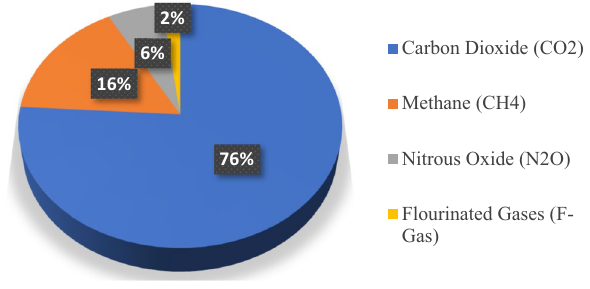
Fig. 1 Greenhouse gas (GHG) Global emission percentage by gas (Intergovernmental Panel on Climate Change 2015)